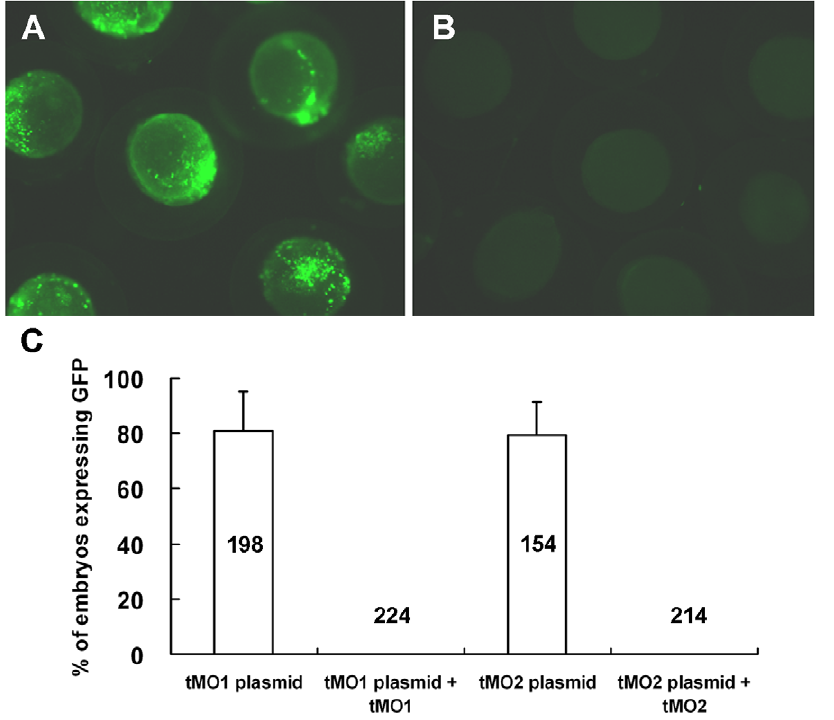
Figure 3. Cfl1 MOs efficiently block the translation of GFP fusion constructs containing respective MO binding site. Embryos at 1-cell stage were injected with 330 pg pCS2 + XLT fused with a fragment of cfl1 gene sequence from 2 22 to + 195 or 2 52 to + 51 in the absence or presence of 7.5 ng cfl1 tMO 1 or tMO 2 , respectively. The expression of GFP was examined at 10 hpf and photographed under epifluorescent microscopy. The representative photos for embryos treated without cfl1 MO (A) and with tMO 1 (B) are shown and the percentages of injected embryos expressing GFP are shown in average 6 standard deviation (C).